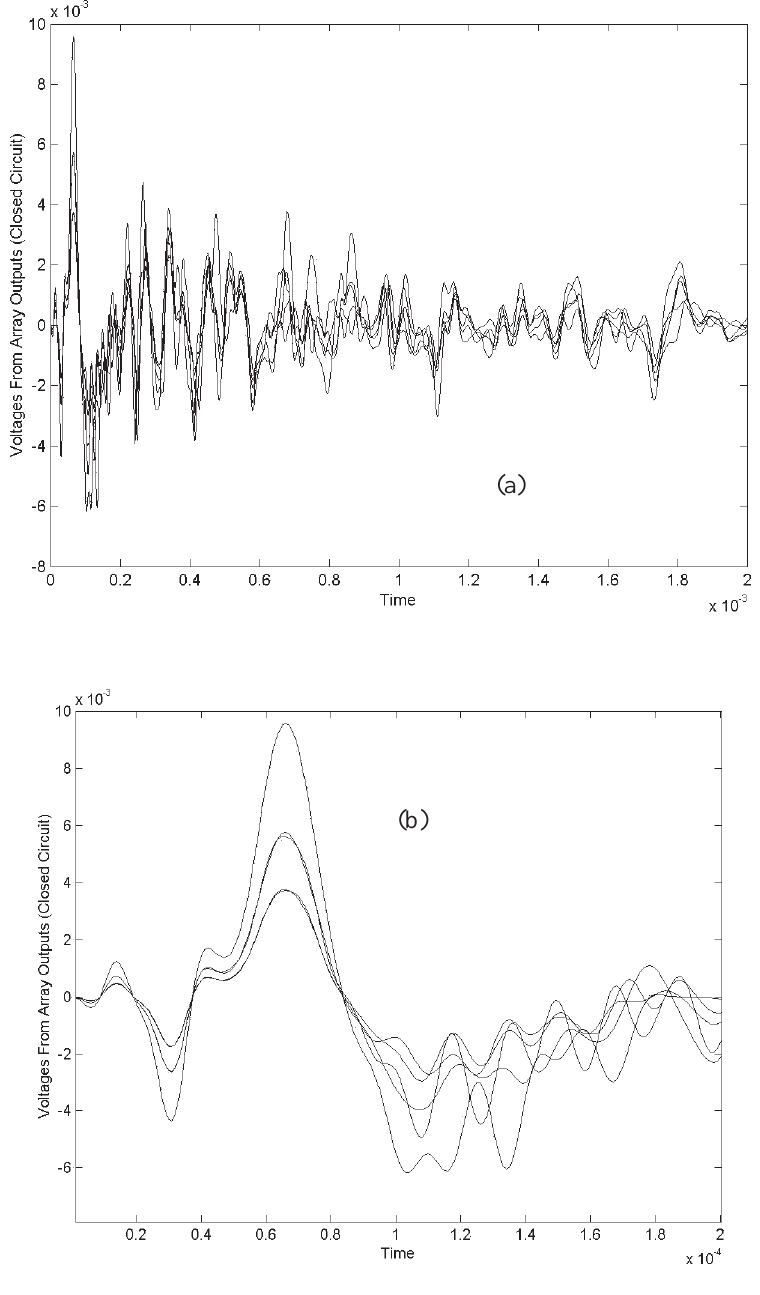
Fig. 9. Voltage time history due to edge actuation by a PZT patch; (a) array voltage for 2 ms, (b) array voltage for 0.2